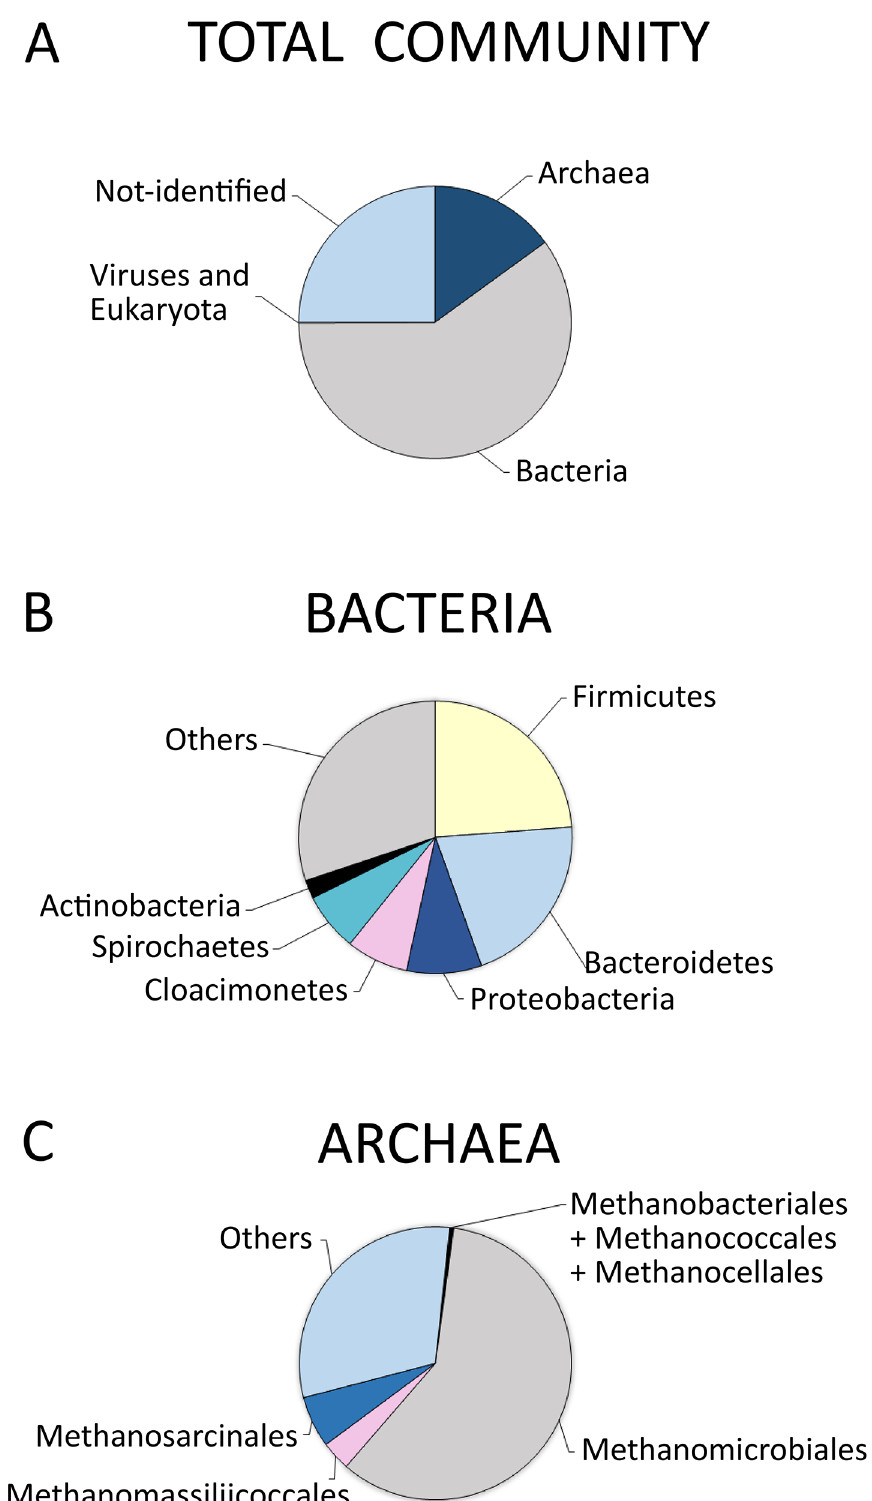
Fig 3. The expected metabolic pathways used for transformation of the components of the acidic effluent from sugar beet molasses fermentation to methane and carbon dioxide in the UASB